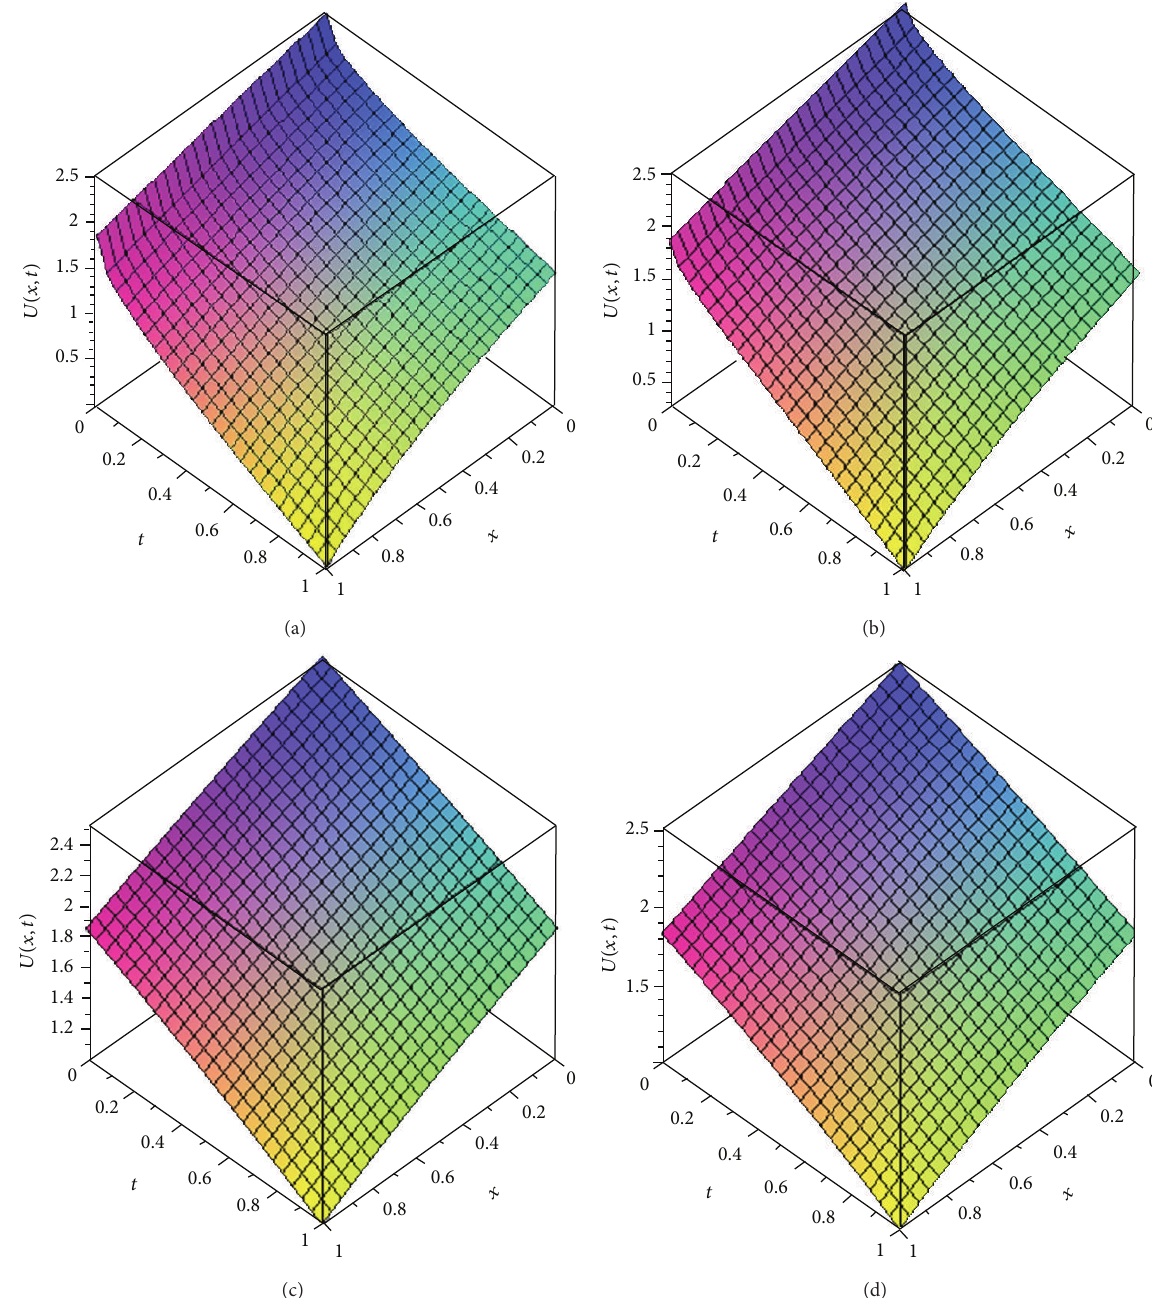
Figure 1: The behaviour of the 𝑈(𝑥,𝑡) with respect to 𝑥 and 𝑡 being obtained, with (a) 𝛼 = 1/3 ; (b) 𝛼 = 1/2 ; (c) 𝛼 = 1 ; (d) exact solution.